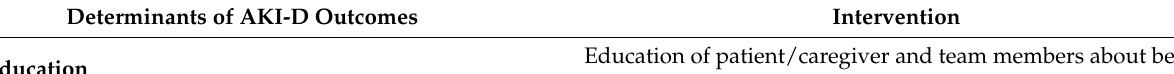
Table 1. Intervention for AKI survivors.